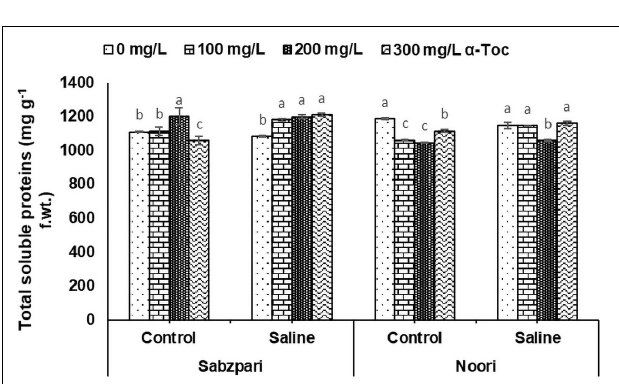
FIGURE 10 | Total soluble proteins of okra varieties sprayed with different levels of α -tocopherol under saline conditions. Values represent means ± S.D. Significant differences among row spacing were measured by the least significant difference (LSD) at p > 0.05 and indicated by different